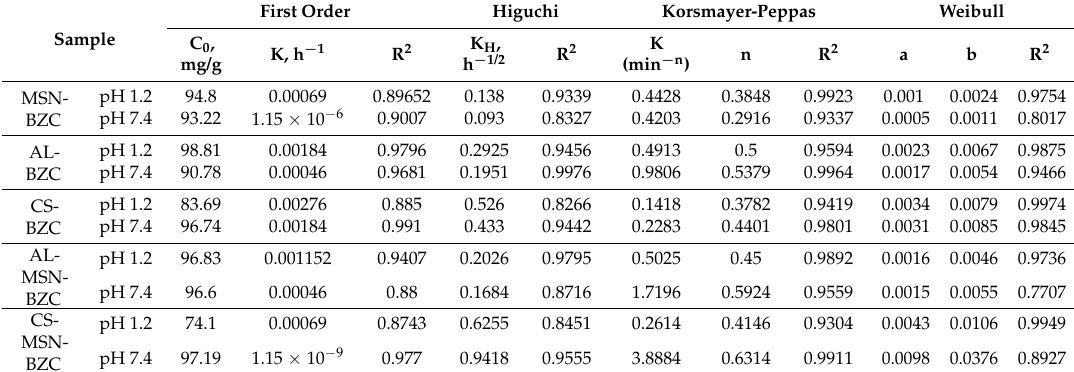
Table 4. Kinetic release parameters of BZC release process from MSN-BZC, AL-BZC,